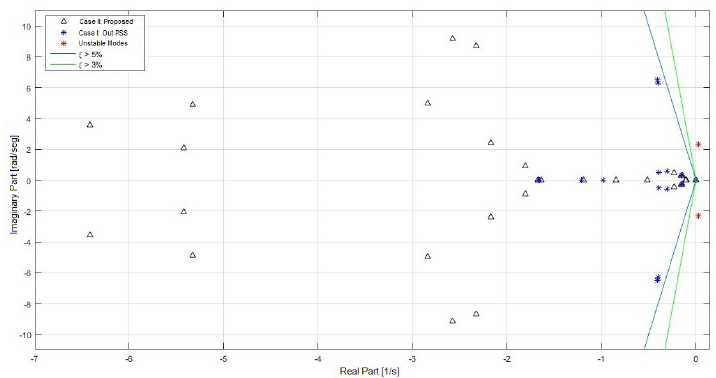
Figure 20. Eigenvalues system II-C1 Line 8–9 out